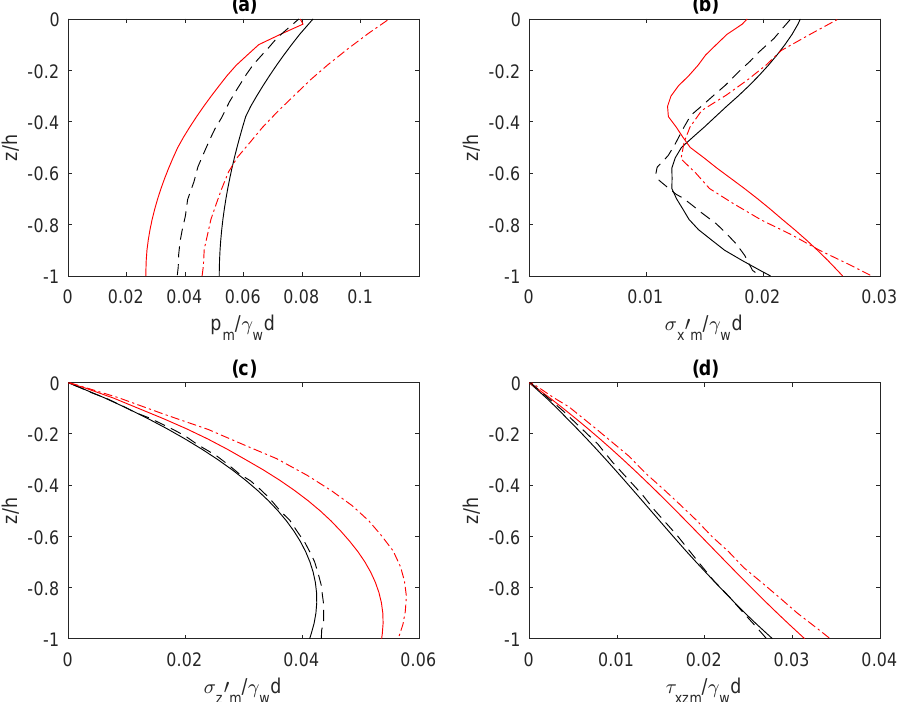
Figure 18. Comparison of the vertical distribution of the maximum soil response under random waves between the present local RBF collocation method (LRBFCM) model. ( a ) pore-water pres- sures ( p m / γ w d ); ( b ) horizontal effective normal stress ( σ (cid:48) xm / γ w d ); ( c ) vertical effective normal stress ( σ (cid:48) zm / γ w d ); and ( d ) shear stress ( τ xzm / γ w d ). Notation: black solid line: B-M spectrum; red solid line: JONSWAP spectrum) and Liu and Jeng [56]’s results (black dashed line: B-M spectrum; red dashed dot line: JONSWAP